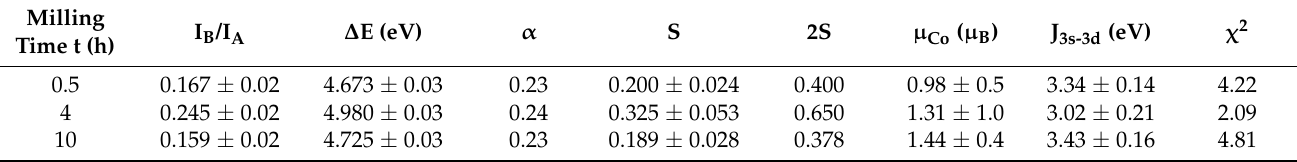
Figure 9. Co3s multiplet splitting determined in as-milled SmCo 5 / α -Fe powders with 5%wt. α -Fe content milled for: ( a ) t = 0.5 h; ( b ) t = 4 h; and ( c ) t = 10 h. Table 4. Magnetic parameters for the SmCo 5 / α -Fe powders with 5%wt. α -Fe content obtained from Co 3s fitting.